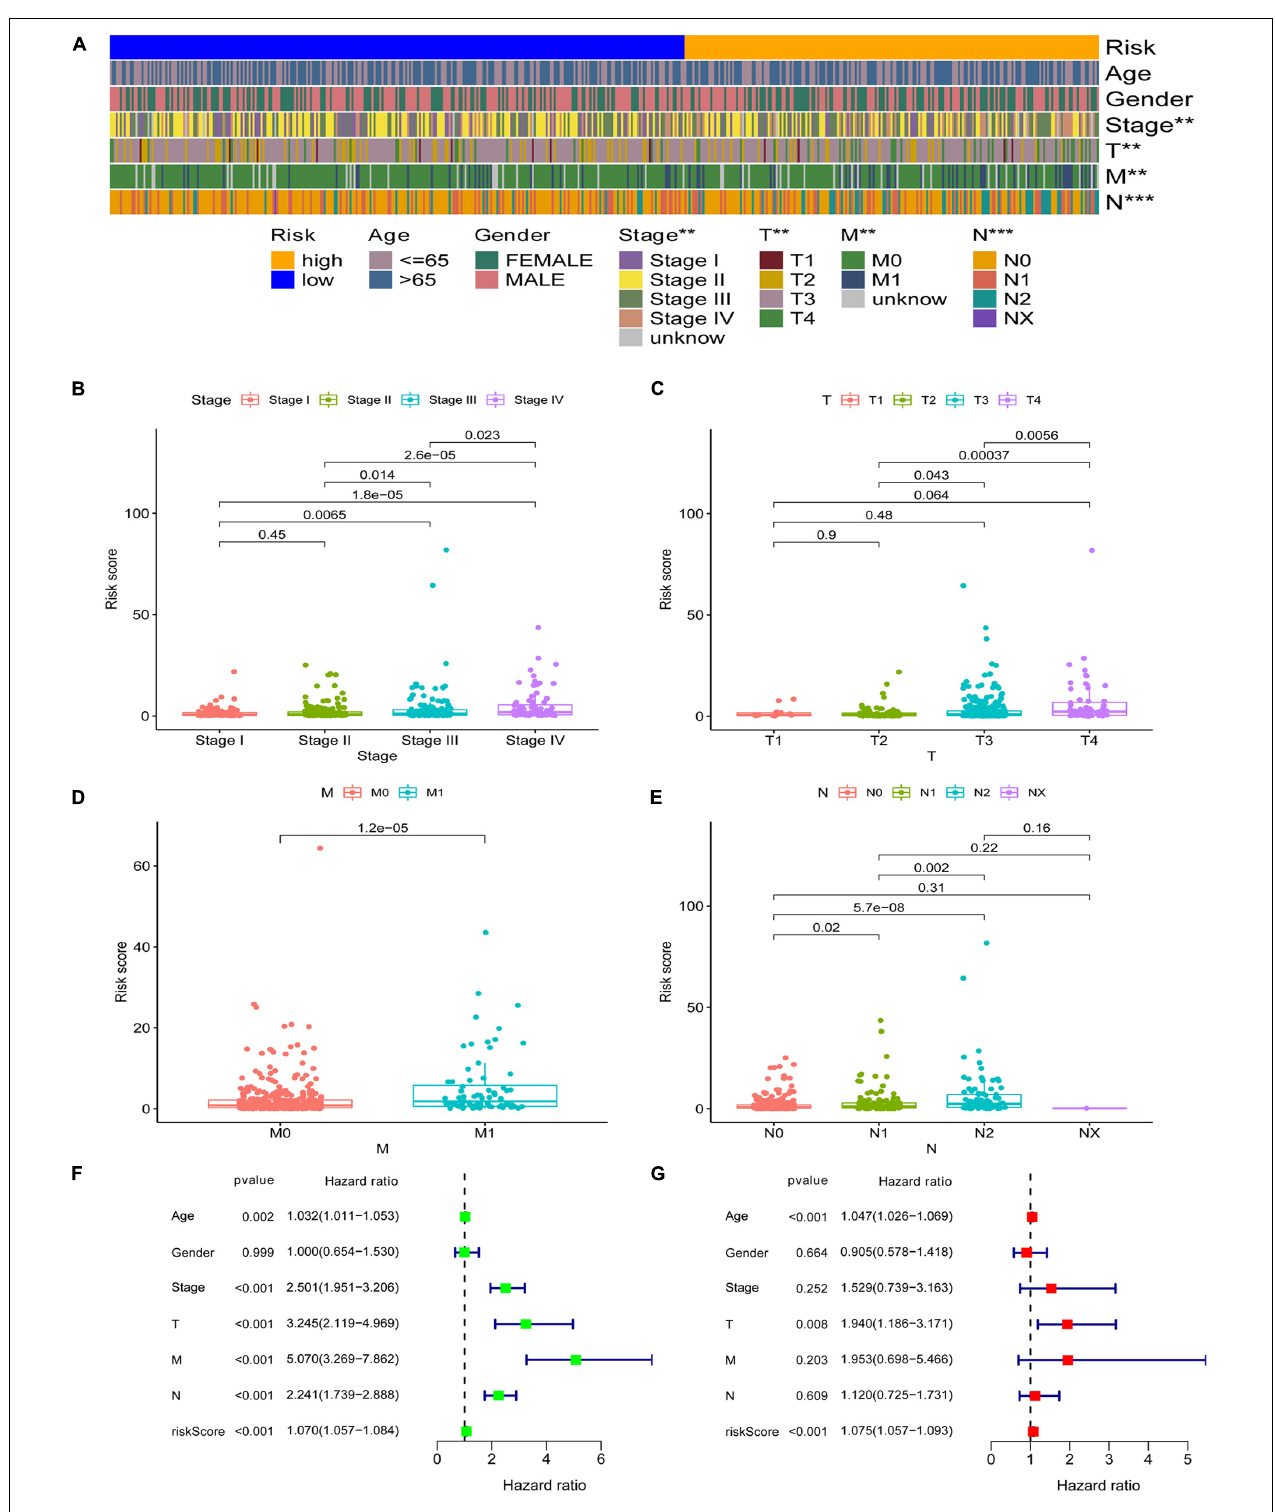
FIGURE 4 | Application of the signature in the clinical evaluation. The band diagram (A) and scatter plots showed that clinical stage (B) , T stage (C) , M stage (D) , and N stage (E) were significantly associated with risk score. Univariate COX regression analysis showed that age, clinical stage, T stage, M stage, N stage, and RiskScore were considered statistically significant (F) . (G) Multivariate Cox regression analysis showed age, T stage, and RiskScore were independent prognostic predictors. ∗∗∗ P < 0.001; ∗∗ P < 0.01; ∗ P < 0.05.